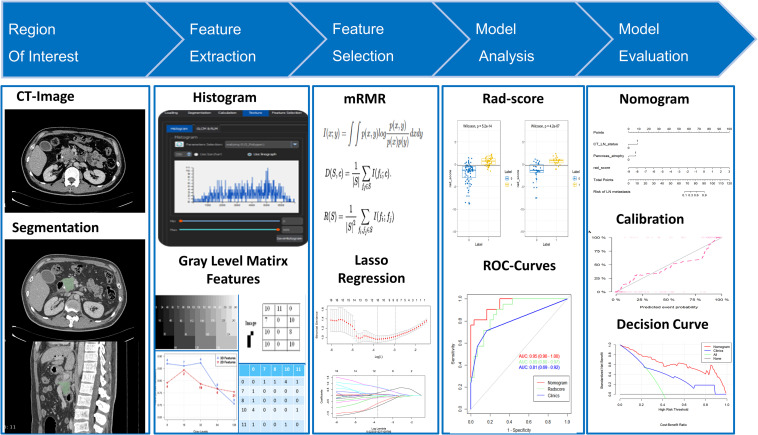
Radiomics workflow.